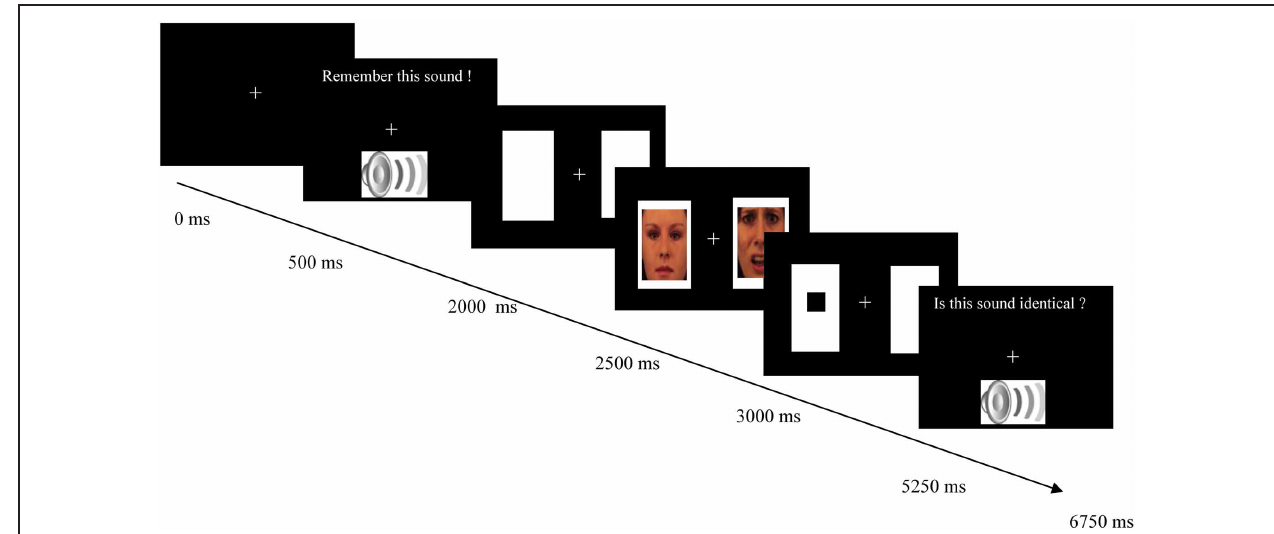
neutral picture. The last box displays the second part of the working memory task in which a second auditory stimulus was presented. Participants had to evaluate whether this sound was identical to the first sound. In experimental condition 2, a different message appeared together with the second sound, namely “Is this sound similar in emotional value?” on half of the trials. On those trials participants had to evaluate whether the second sound was similar to the first sound in valence, which was either neutral, negative, or